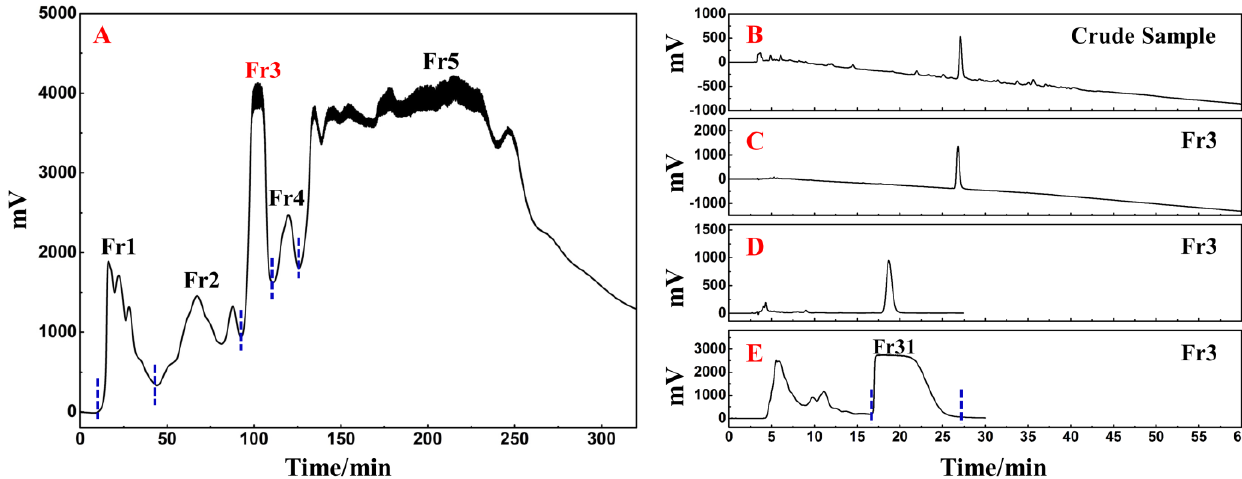
Figure 8. Separation chromatograms of D. heterophyllum ethyl acetate extracts mixed with amorphous silica gel ( A ). Conditions: mobile phase A: water and B: MeOH; gradient: 0–35 min, 0% B, 35–195 min, 0–100% B, 195–320 min, 100% B; monitoring wavelength: 210 nm; flow rate: 57.0 mL/min; sample loading: 90.0 g of D. heterophyllum ethyl acetate extract amorphous silica gel combination; column temperature: room temperature. The analytical chromatogram of the D. heterophyllum ethyl acetate extraction ( B ) and fraction Fr3 ( C , D ) on a 7-X10 analytical column. Preparative chromatogram ( E ) of the main component Fr31 sample on a 7-X10 preparative column. Conditions: mobile phase A: 0.1% formic acid in water, B: MeOH; gradient elution for ( B , C ): 0–60 min, 0–100% B; isocratic elution for ( D , E ): 0–30 min, 30% B; flow rate for ( B – D ): 1.0 mL/min, for ( E ): 19.0 mL/min; monitoring wavelength: 210 nm; injection volume for ( B , D ): 2 µ L, for ( E ): 1.0 mL; column temperature for ( B – D ): 30 ◦ C, for ( E ): room